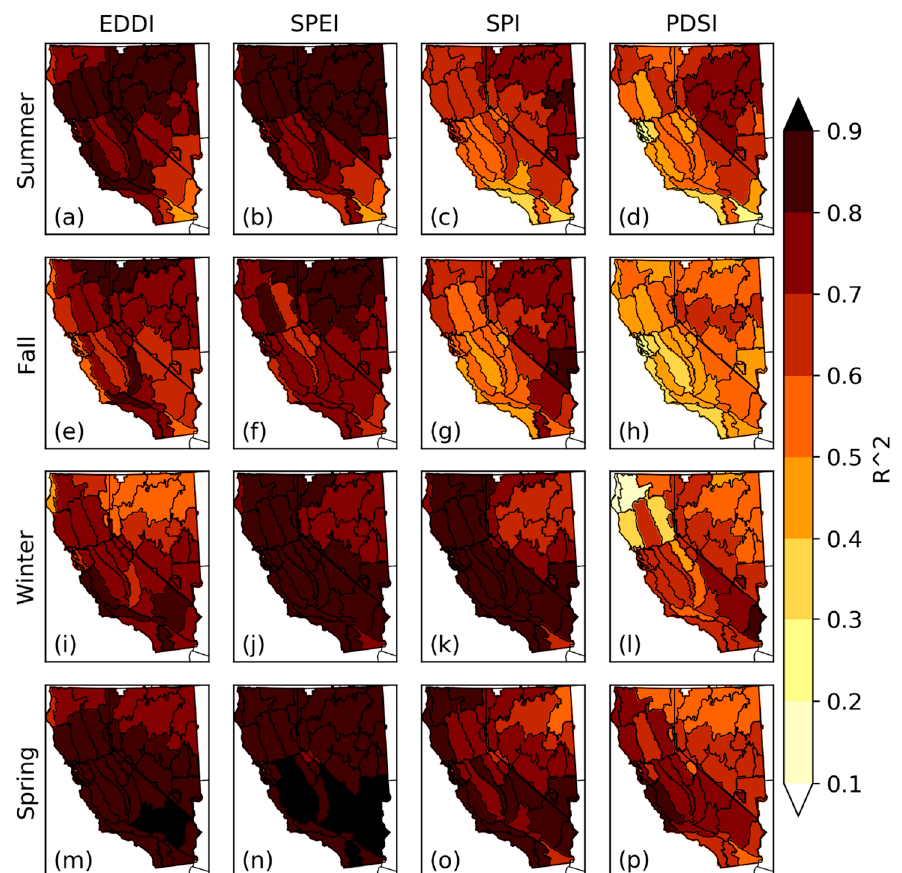
Figure 3. Maximum R 2 of each drought index with the seasonal 1000-hr fuel moisture fire danger output by season across the period 1979–2015 for each PSA in California and Nevada. Drought indices include ( a , e , i , m ) EDDI, ( b , f , j , n ) SPEI, ( c , g , k , o ) SPI, and ( d , h , l , p ) PDSI and seasons include ( a , b , c , d ) summer, ( e , f , g , h ) fall, ( i , j , k , l ) winter, and ( m , n , o , p ) spring.